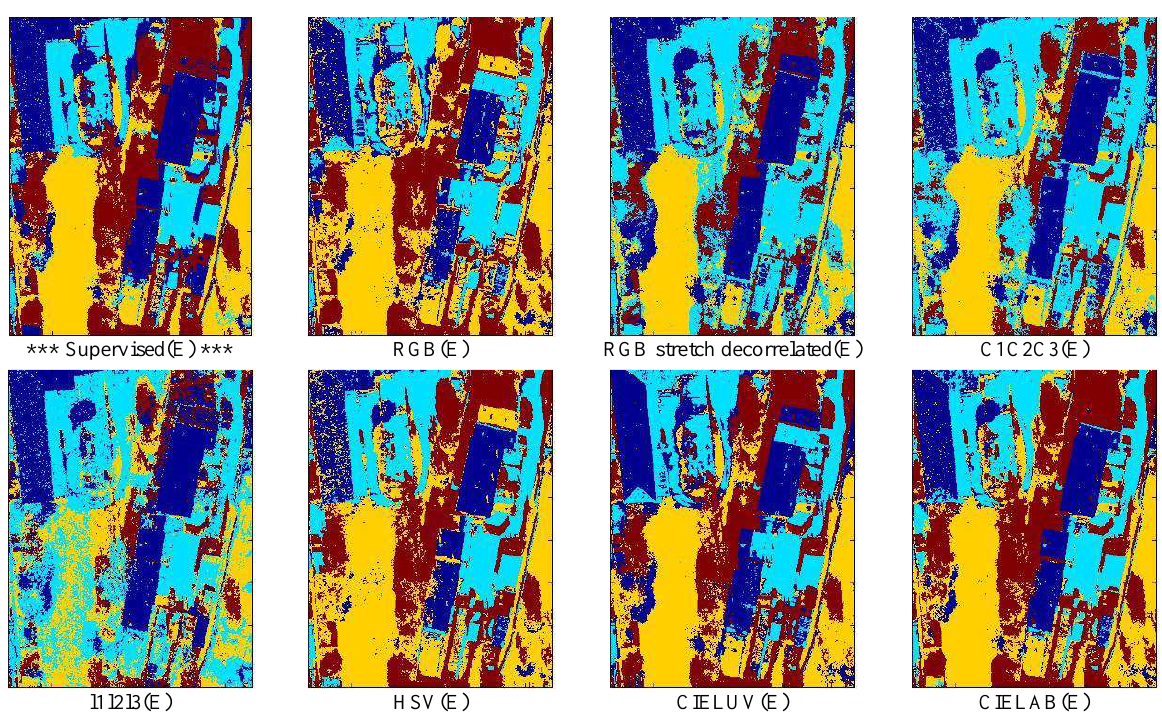
Figure 4: Examples of K-Means classifications of Image 1_2011 at 27 cm with different vector components: here blue represents urban areas, cyan identifies streets, yellow vegetation, and brown shadows. (E) indicates Euclidean